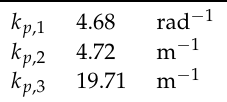
Table 4. Controller parameters from minimization.